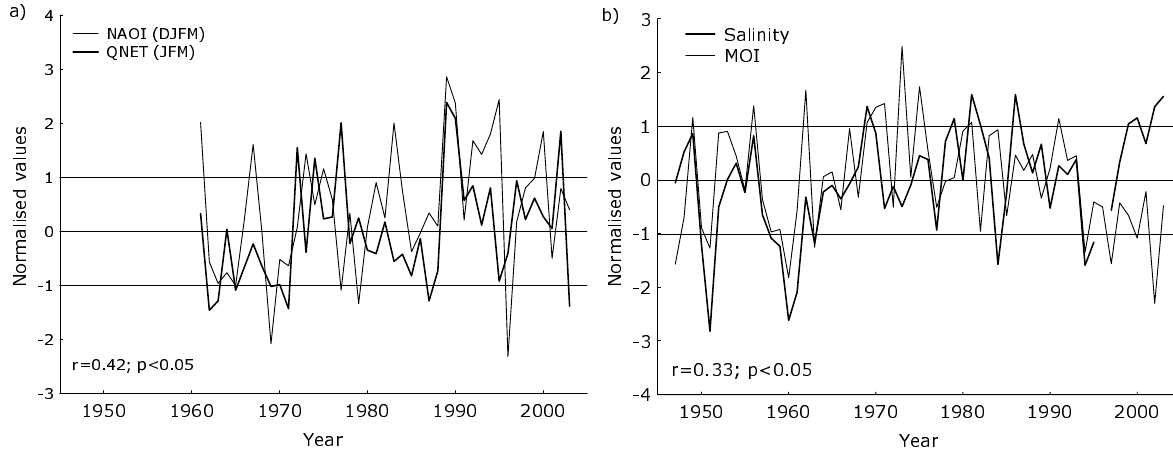
Fig. 8. Time series of normalized mean winter heat flux at Split-Marjan and NAOI for the 1961–2003 period (a) and time series of normalized annual mean salinity at CJ009 station and MOI for the 1948–2003 period (b)